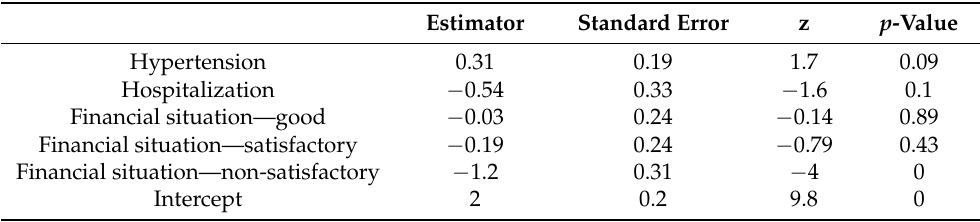
Table 4. Question six—logistic regression model; two or more responses indicating the satisfactory level of knowledge.